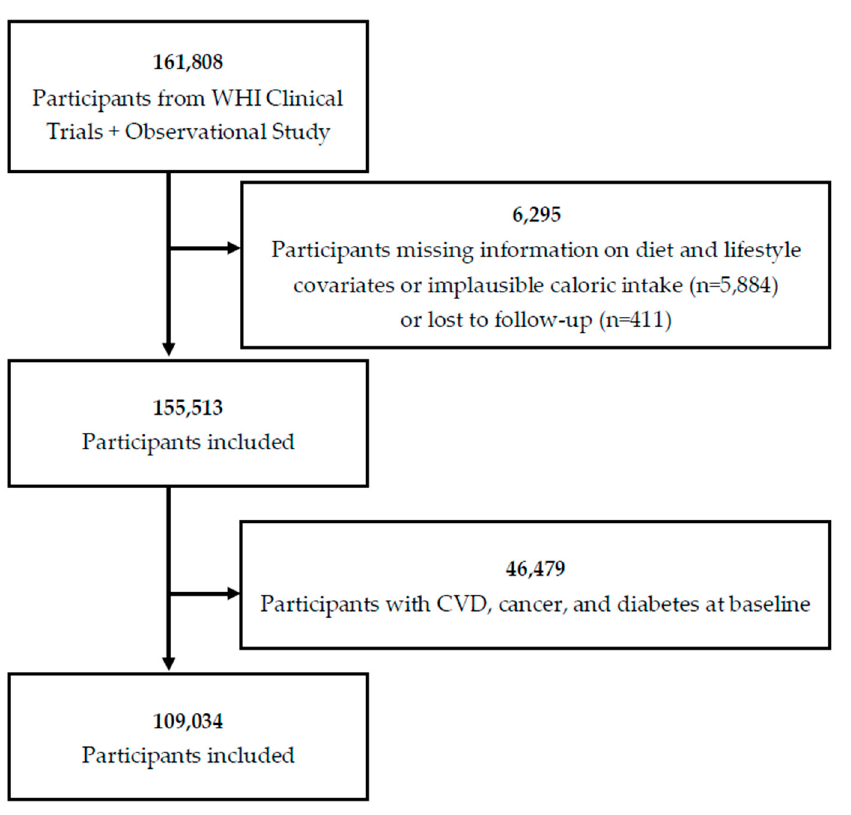
Figure 1 . Flow chart for the study sample: Women’s Health Initiative (WHI) cohort, 1993–2021. Figure 1. Flow chart for the study sample: Women’s Health Initiative (WHI) cohort,